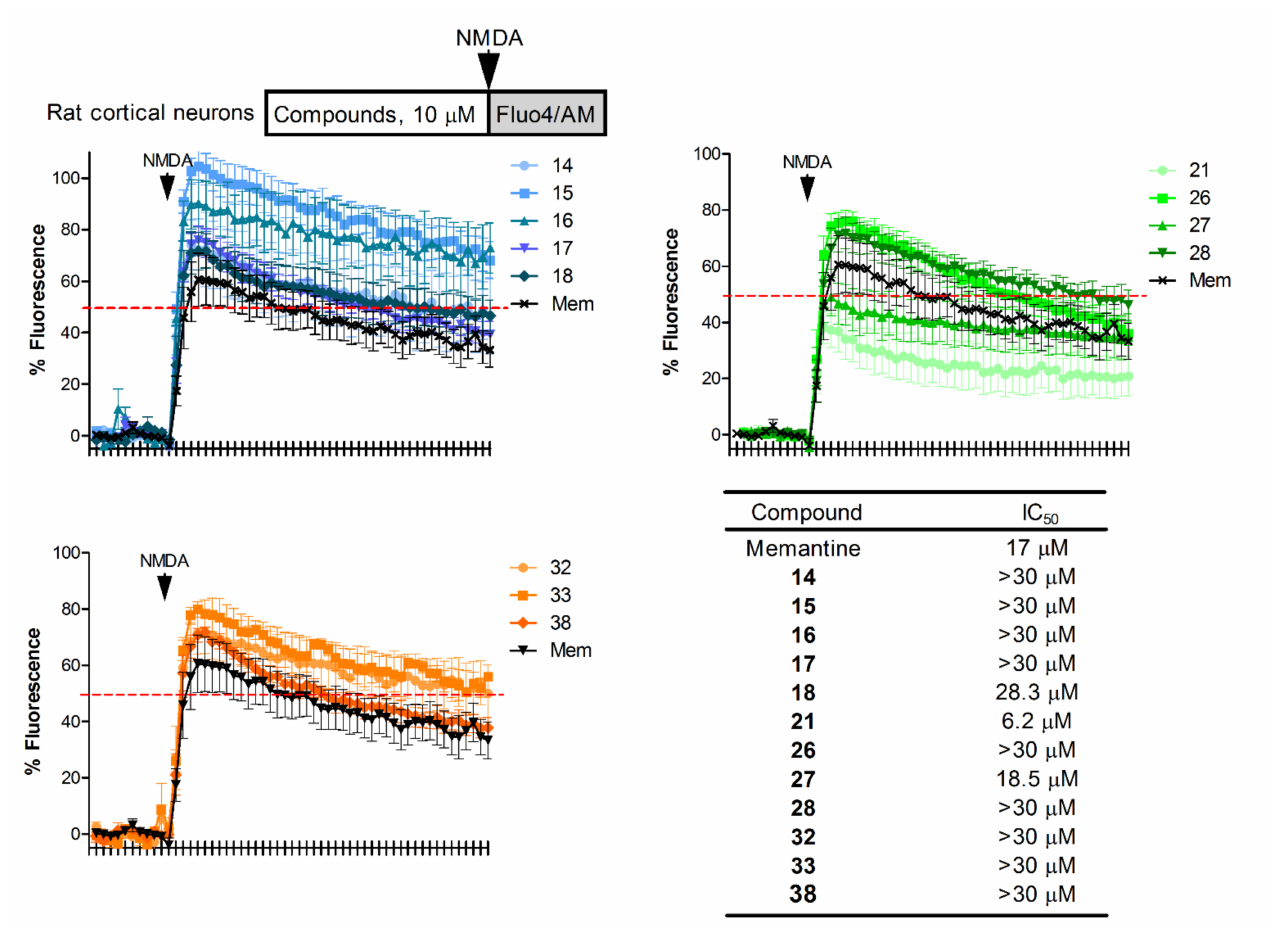
Figure 4. Representative fluorescent curves of [Ca 2+ ] c oscillations for each test compound and the standard memantine (Mem), at the concentration of 10 µ M. The curves represent the % of fluorescence compared to a control situation, i.e., cells just stimulated with NMDA 10 µ M, and they are the mean ± SEM of at least 3 independent experiments by triplicate. Bottom right, table with the IC 50 data calculated from experiments using compounds concentrations from 1 to 30 µ